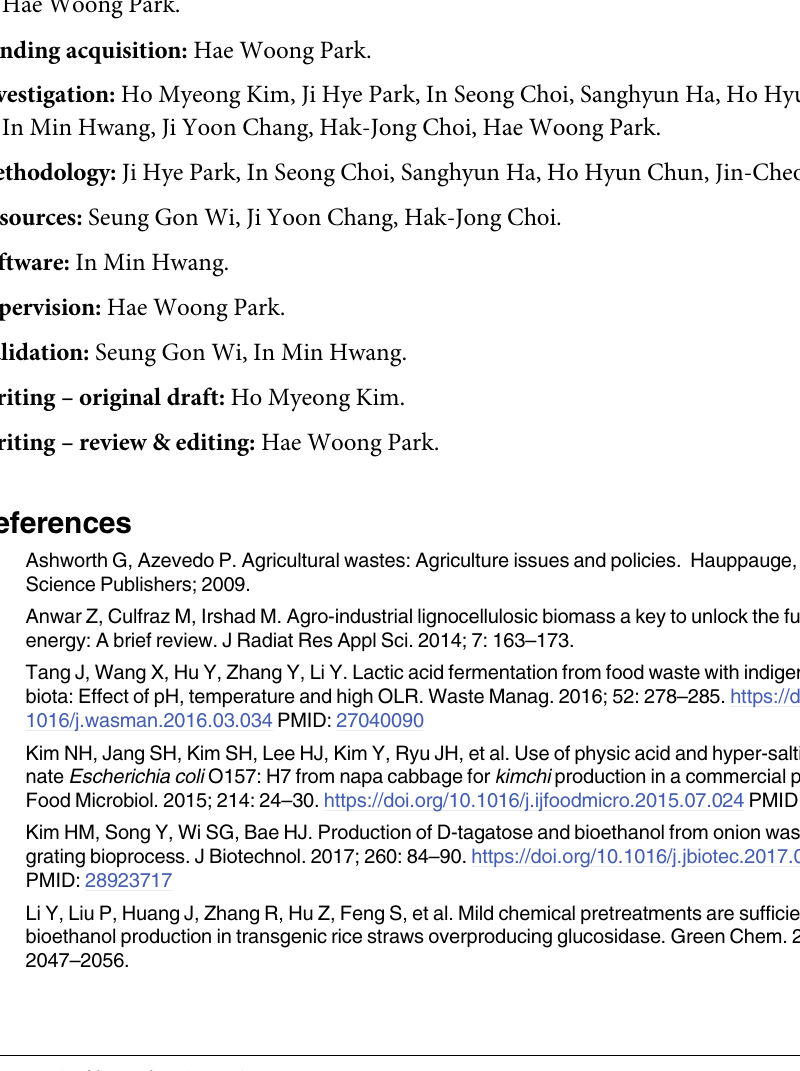
S1 Table. Reducing sugar concentration of KCW hydrolysate under different enzyme load- ing